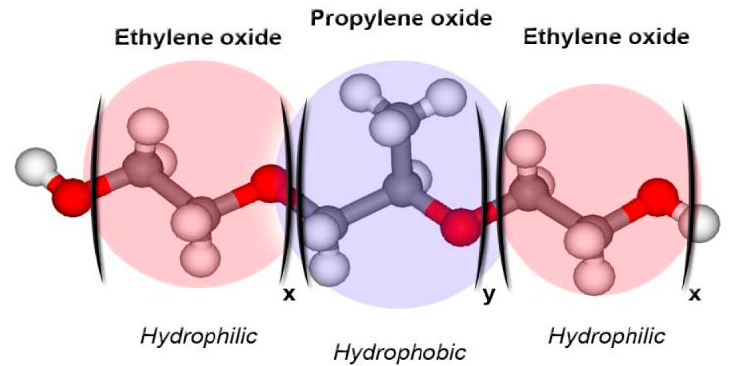
Figure 1. Schematic representation of the structure of poloxamer derivatives [22].